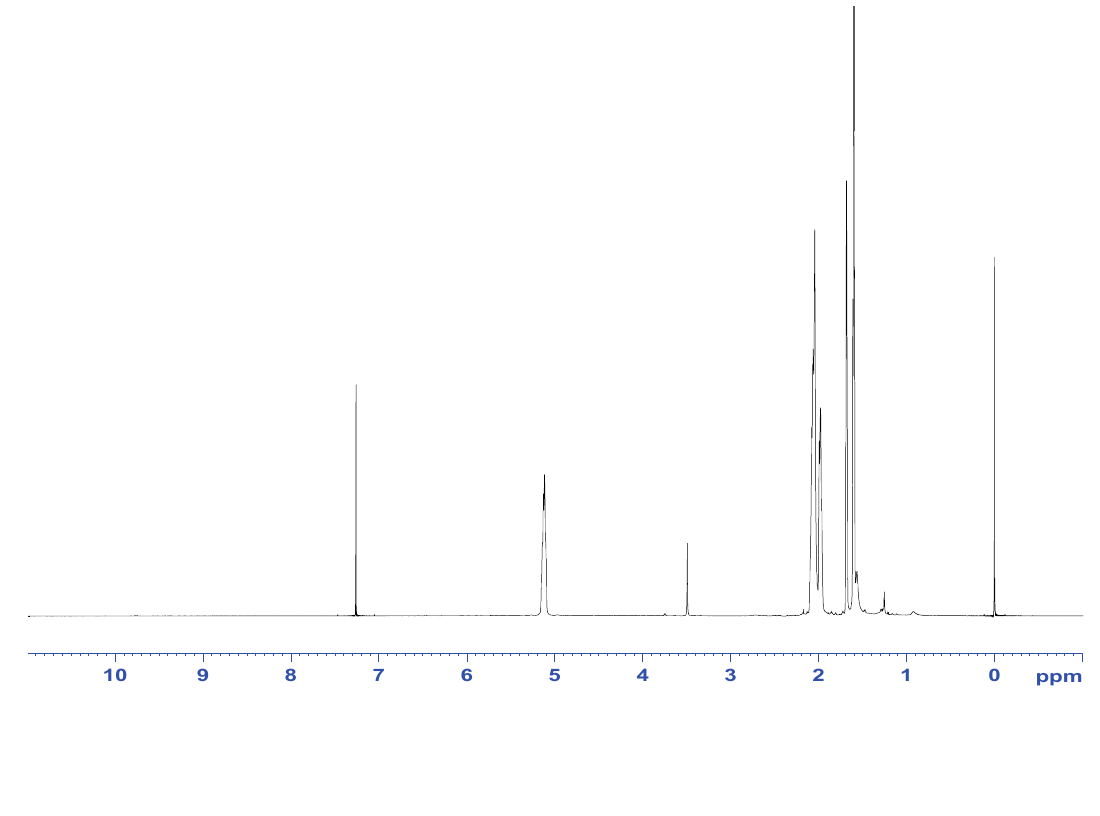
Figure 6. 1 H NMR spectrum of LNR prepared in acidic